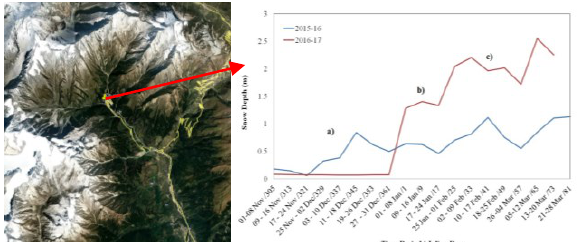
Figure 20. SPA at Dhundi & SD data for 2016-17 winter seasons (SPA worked till Feb 2019, damaged in heavy snowfall of 2019, SD/SWE data from Oct.2015-Feb. 2019).